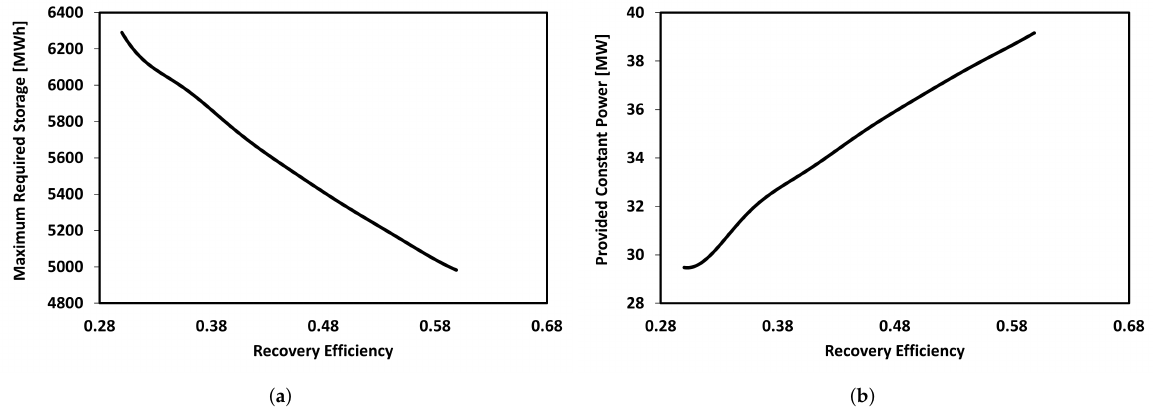
Figure 9. Sensitivity analysis of energy storage size and constant power with recovery efficiency, η r . ( a ) Maximum required storage. ( b ) Provided constant power.